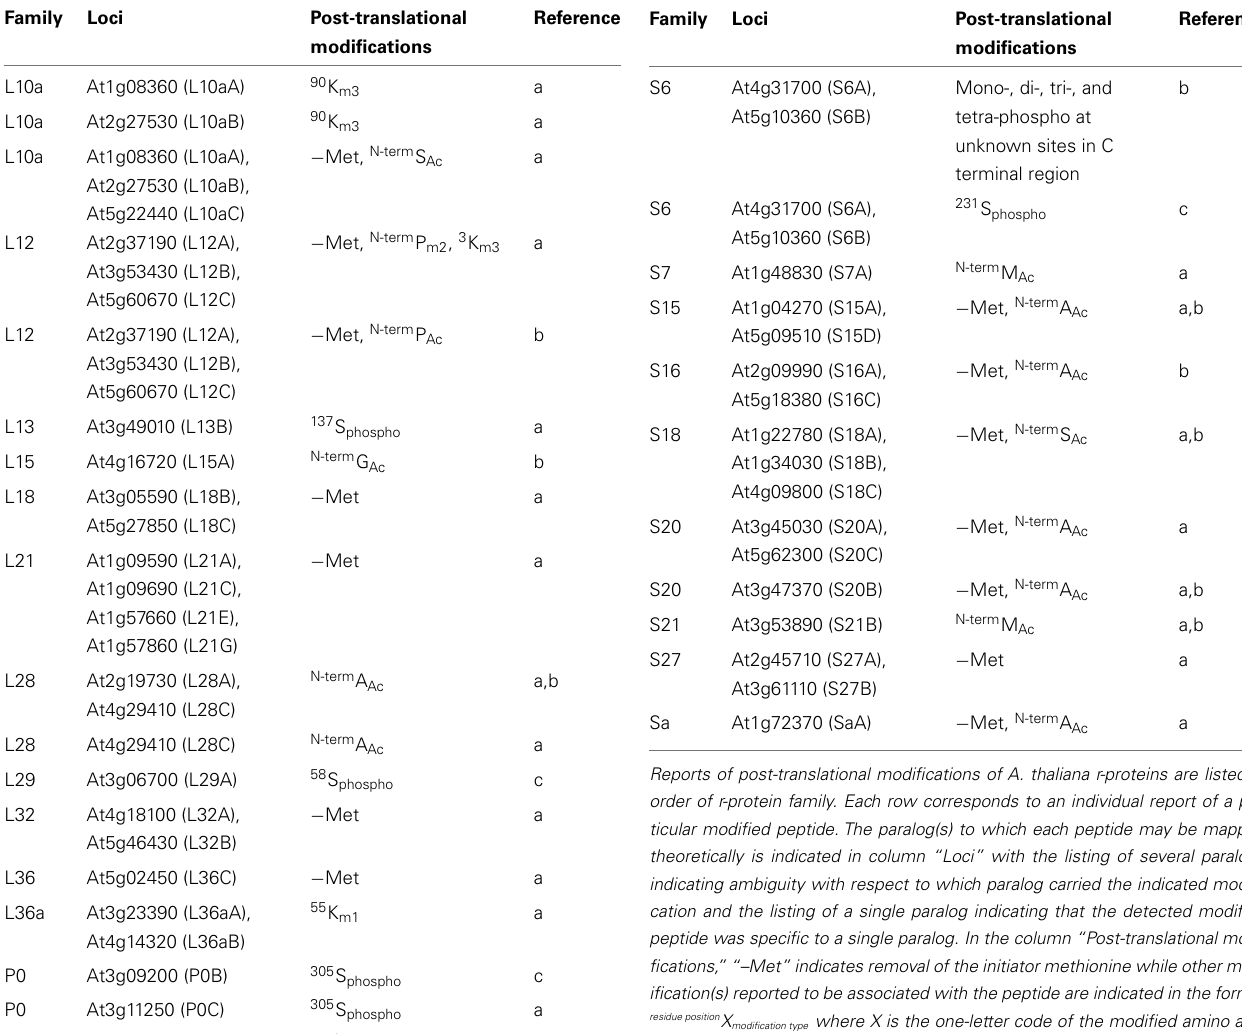
Table 2 | Post-translational modifications reported to date in A. thaliana ribosomal